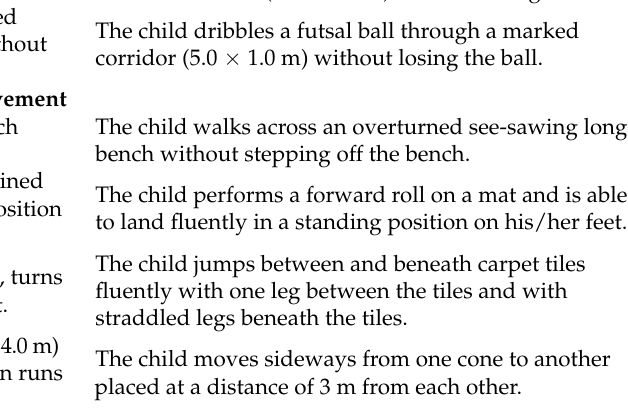
Table 1. Cont. MOBAK-KG MOBAK-1-2 The child bounces a small basketball through